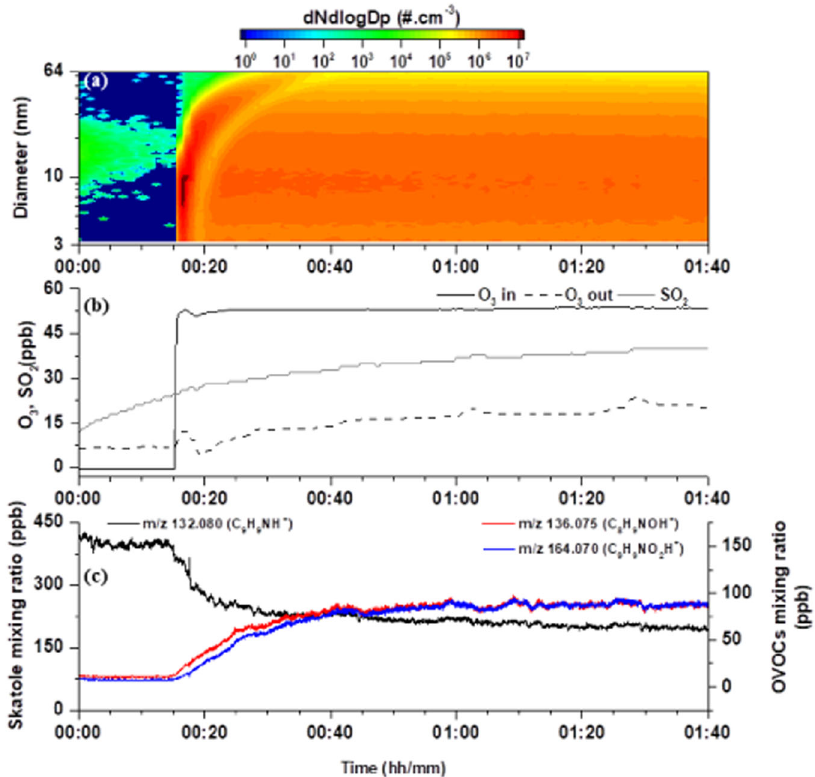
Fig. 1 Typical sewage sludge ozonolysis experiment. a Temporal evolution of the particle number concentration and size distribution. The ordinate represents the electrical mobility diameter (nm), and the color scale represents the particle number concentration. b Temporal evolution of O 3 entering the chamber (black line, O 3 in), O 3 measured at the exit of the chamber (black dotted line, O 3 out) and SO 2 (gray line). c Temporal evolution of m/z 132.080 C 9 H 9 NH + (black line, left axis), m/z 136.075 C 8 H 9 NOH + (red line, right axis), and m/z 164.070 C 9 H 9 NO 2 H + (blue line, right